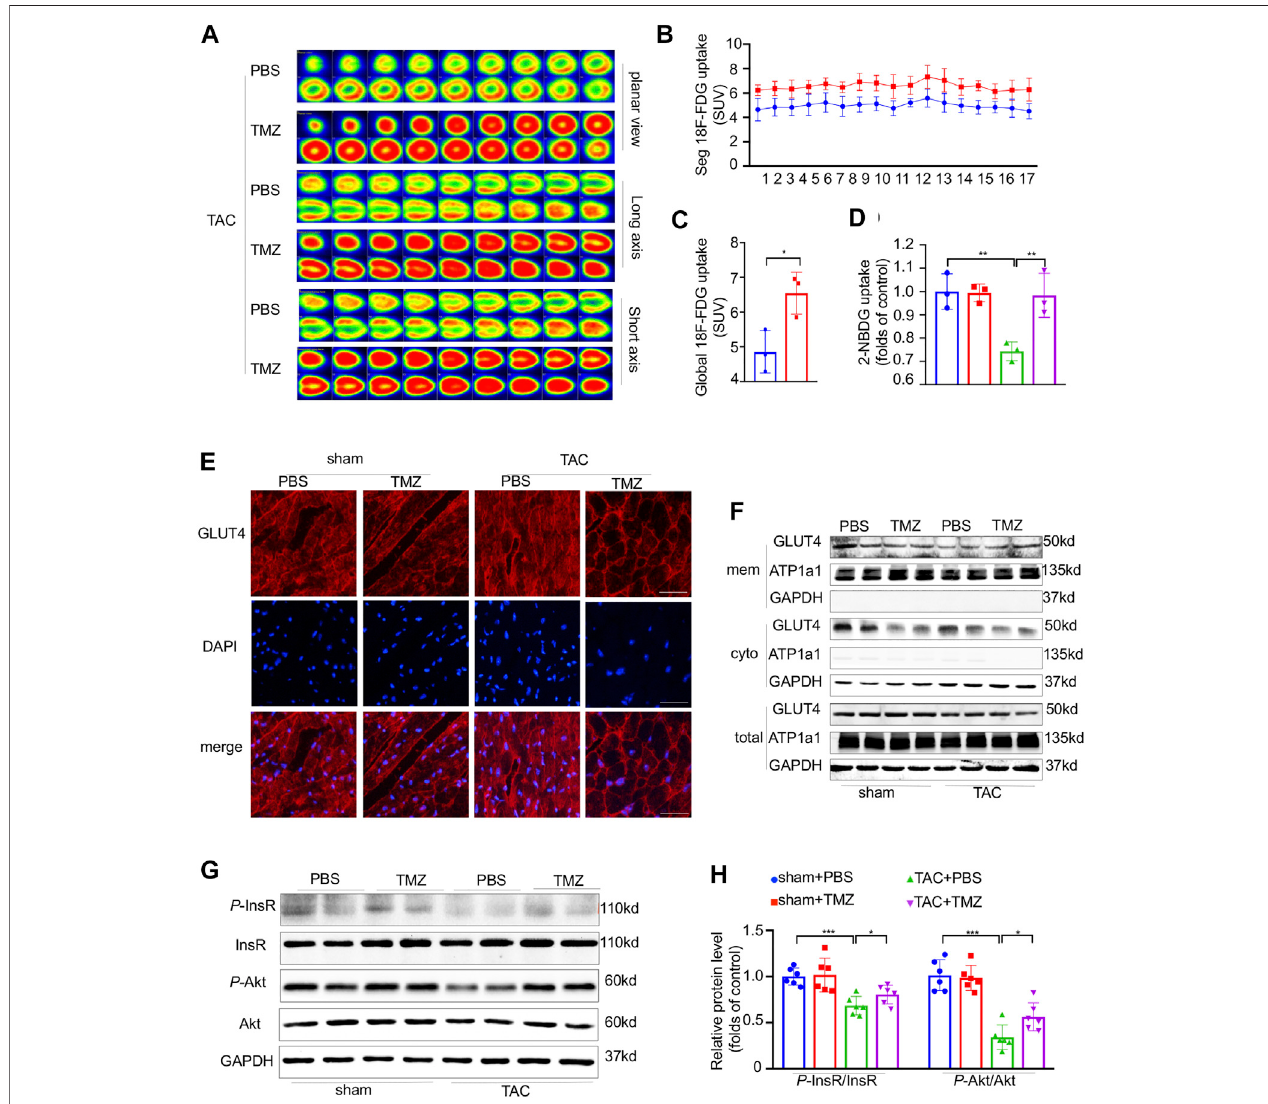
FIGURE3| Trimetazidine attenuated thecardiac insulin resistance evokedbypressure overload. (A) RepresentativePET images showing theglucose uptakerate of mice heart, and corresponding calculated results (B,C) n (cid:2) 3. (D) Glucose uptake rate of isolated adult cardiomyocytes by 2-NBDG assay, n (cid:2) 3. (E) Immuno fl uorescence staining images labeling GLUT4 (red) and DAPI (blue) in mice heart tissue. Scale bar (cid:2) 50 um. (F) Representative western blots of GLUT4 in membraneandcytoplasminindicatedgroups,GAPDHwasusedascytoplasmloadingcontrolandthetotalproteincontrol,Na-K-ATPasewasusedasmembrane loading control. (G,H) The protein levels of InsR, Akt and their phosphorylation states, n (cid:2) 6. Graphical data are shown as mean ± SEM. Two-way ANOVA was used for analysis. * p < 0.05, ** p < 0.01, *** p < 0.001 vs indicated group. TAC, Transverse aortic constriction; TMZ, Trimetazidine; SUV, Standard uptake value.